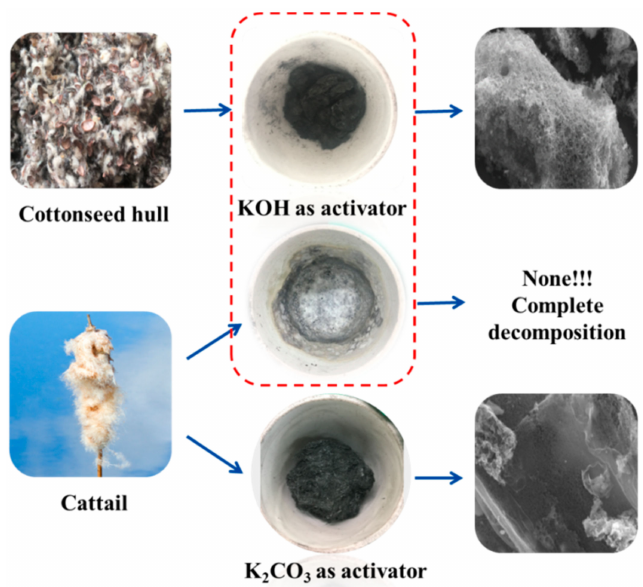
Figure 2. Preparation of porous carbon materials with di ff erent activator.